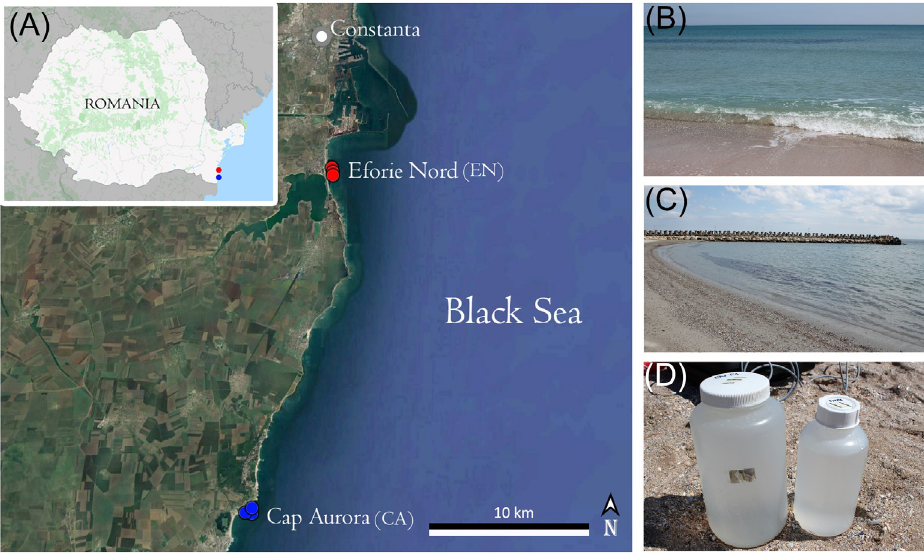
Figure 1. Black Sea sampling. ( A ) Satellite image (obtained with Google Earth Pro) showing the geographic locations of the sampling sites; ( B ) EN sampling location; ( C ) CA sampling location; ( D ) Collected water samples. The photos ( B – D ) were taken by L. Iancu.